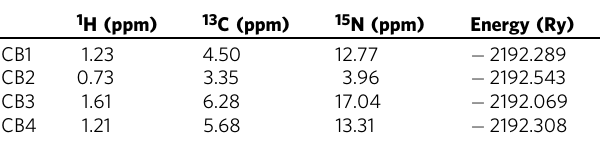
Table 2 RMSD values of chemical shifts for cimetidine